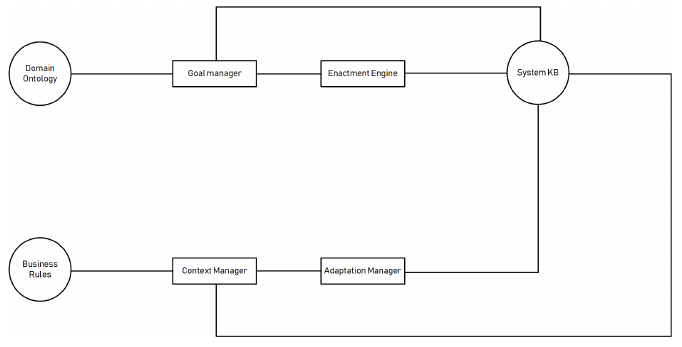
Figure 4. An architecture of an EC management